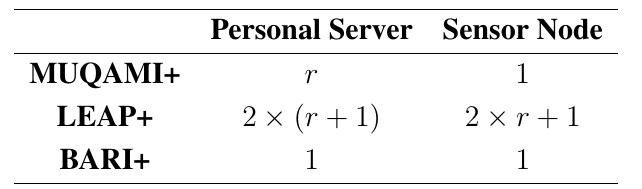
Table 5. Average number of messages transmitted by each type of node in initial deployment phase of all three